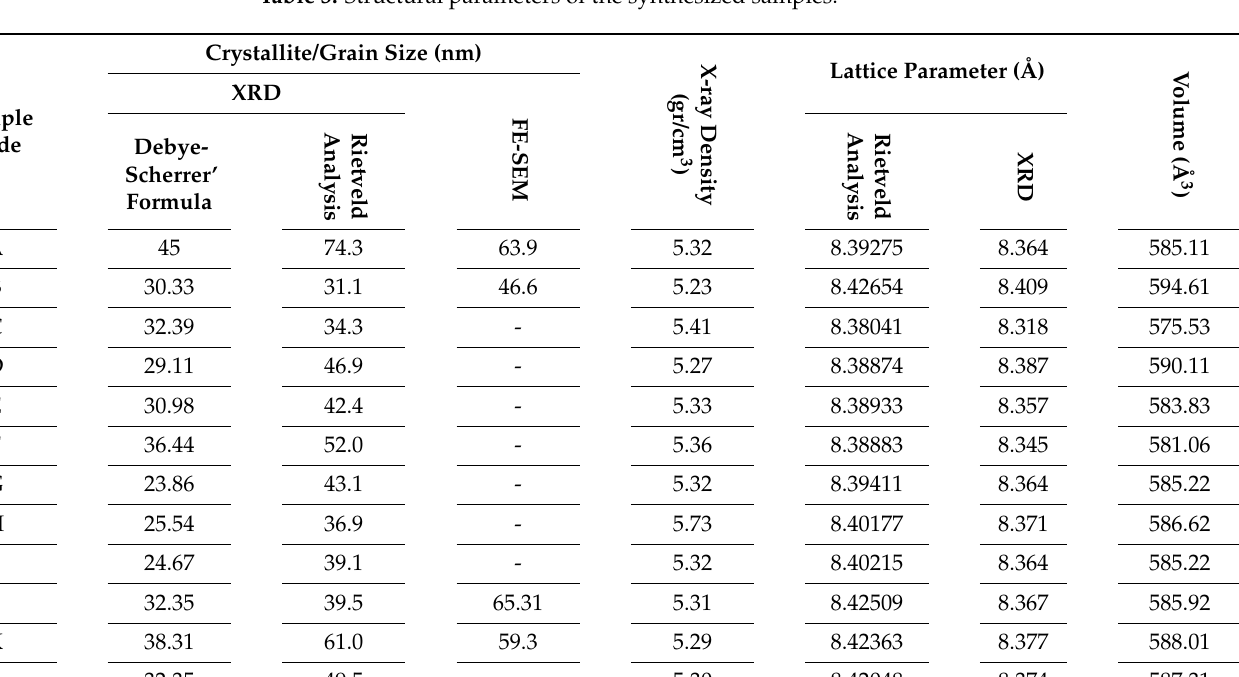
Table 3. Structural parameters of the synthesized